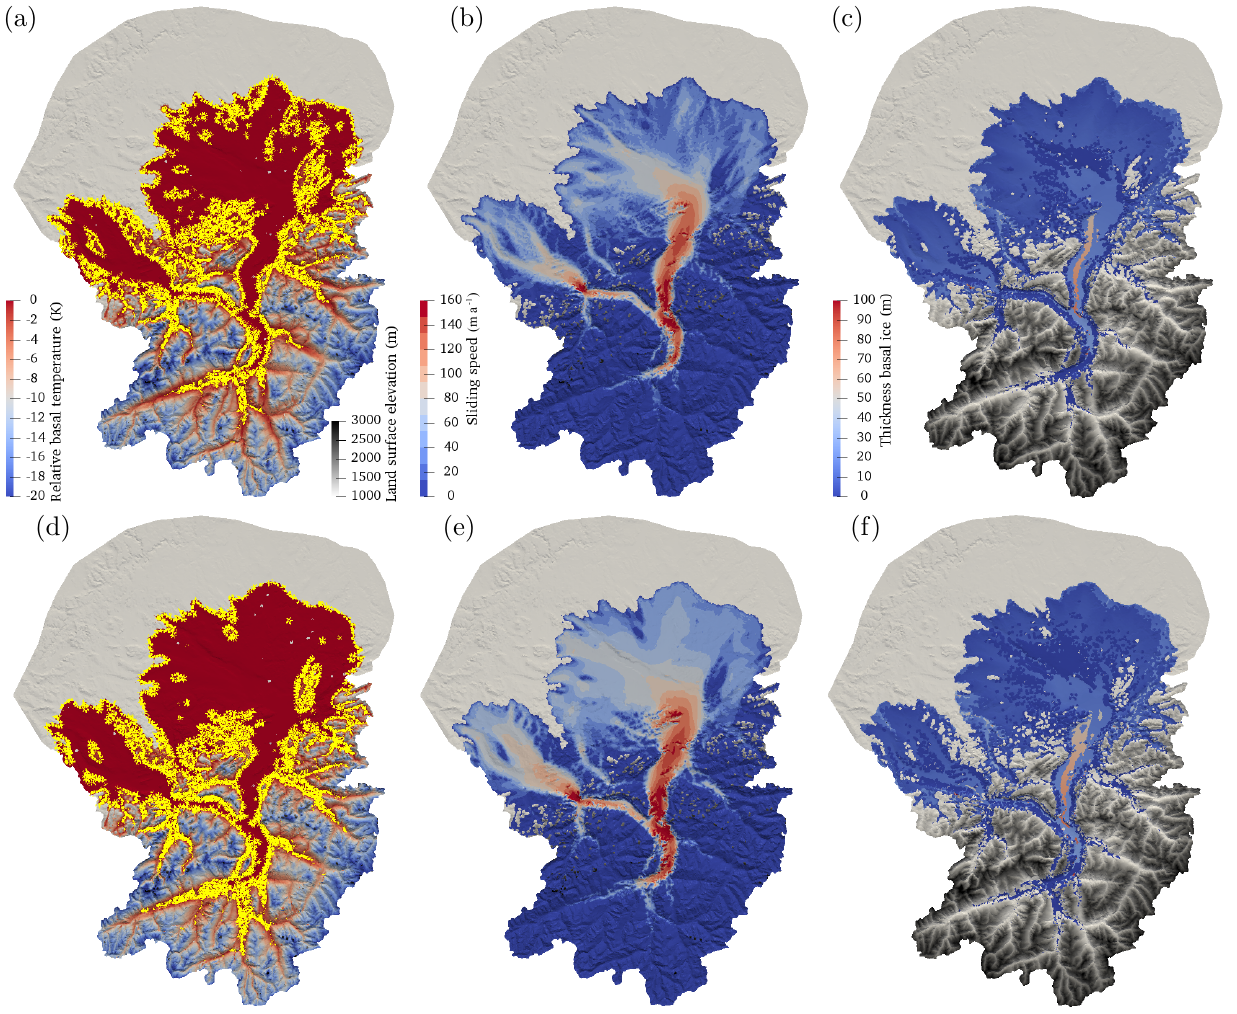
Figure 16. Effect of basal friction on basal temperature, sliding speed, and basal ice thickness for simulation s5 at t = 1540a. (a–c) No basal friction; (d–f) with basal friction. (a, d) Basal temperature. (b, e) Sliding speed. (c, f) Thickness of temperate basal ice layer. Basal friction was turned on for 200 years. Note also the slightly larger extent of ice for the simulation with basal friction